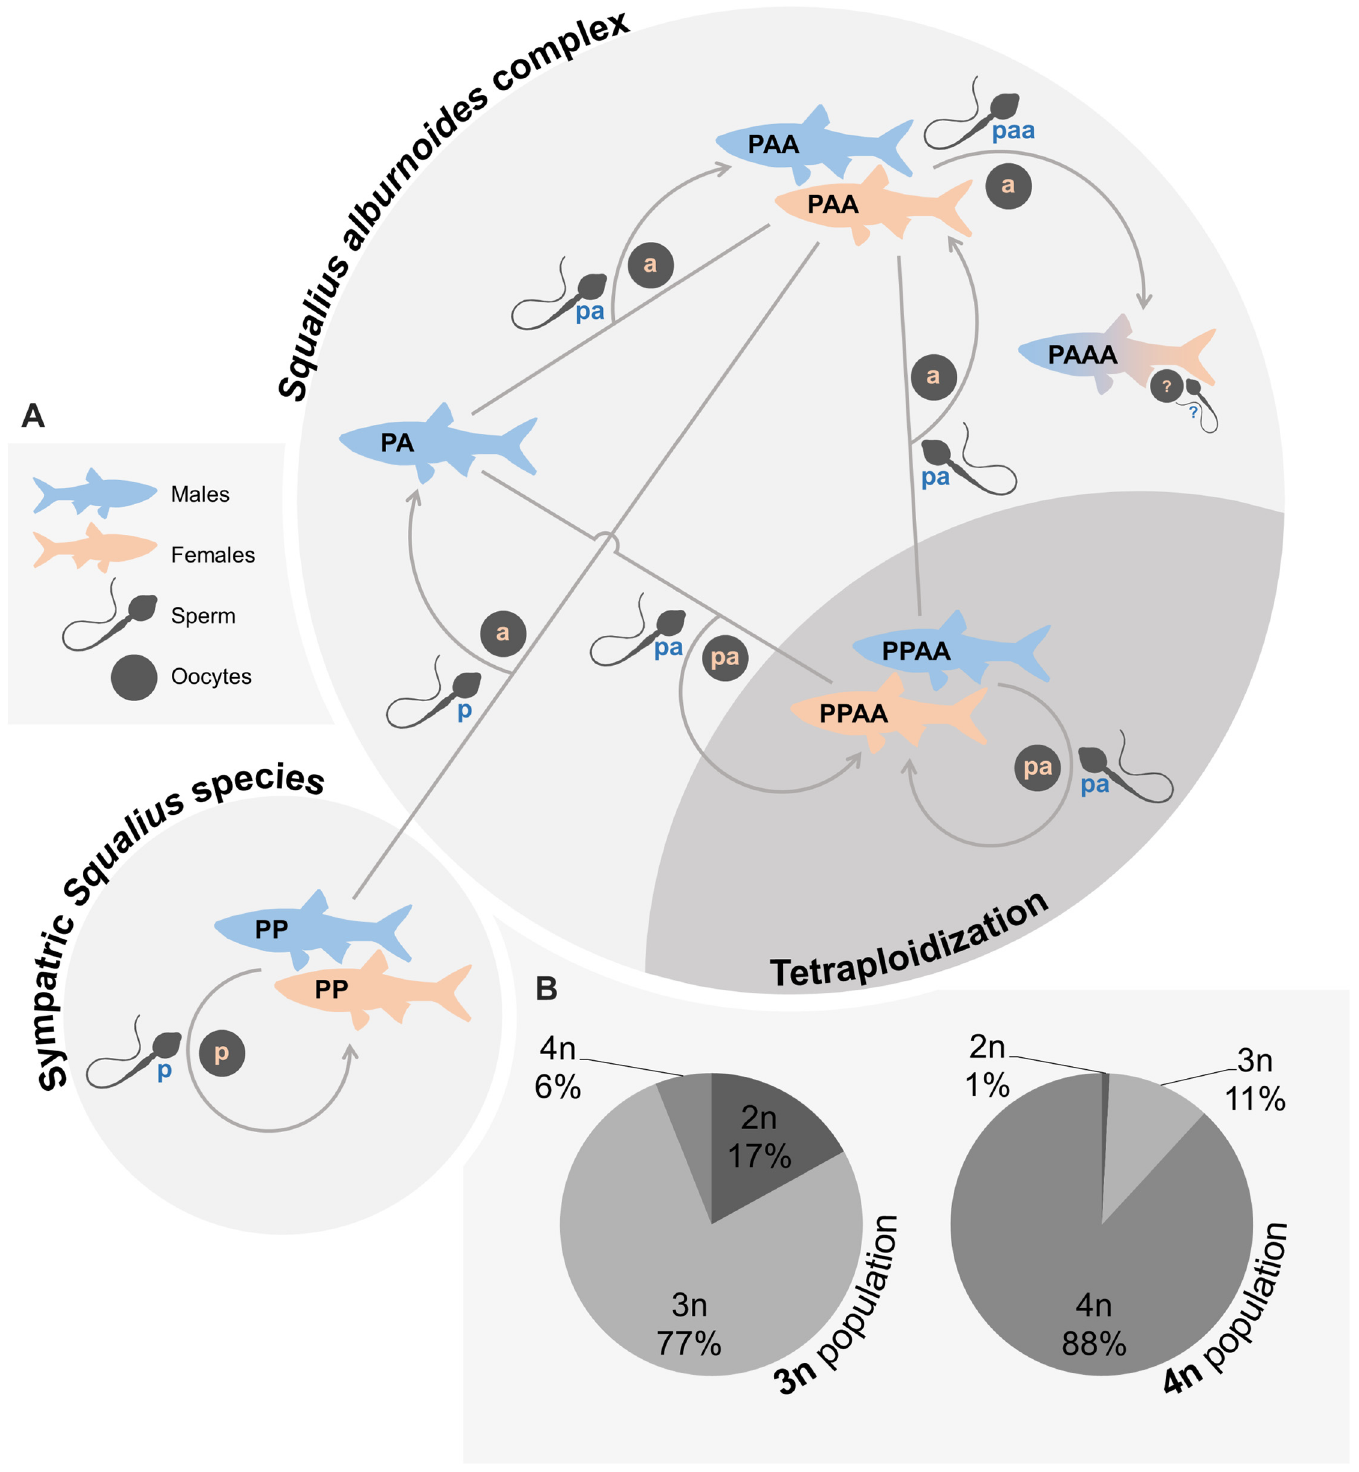
Fig 1. Reproductive dynamics and example genomotype compositions of the S . alburnoides complex. A. Simplified diagram of S . alburnoides reproductive dynamics in a triploid-dominated (light grey area) and in a tetraploid-dominated (dark grey area) populations. See Introduction for more details about the reproductive modes of each genomotype. The genome nomenclature used was based on central and southern populations where the bisexual Squalius non-hybrid species is S . pyrenaicus (PP). Other non-hybrid Squalius species are also sympatric with S . alburnoides in other geographic regions ( S .